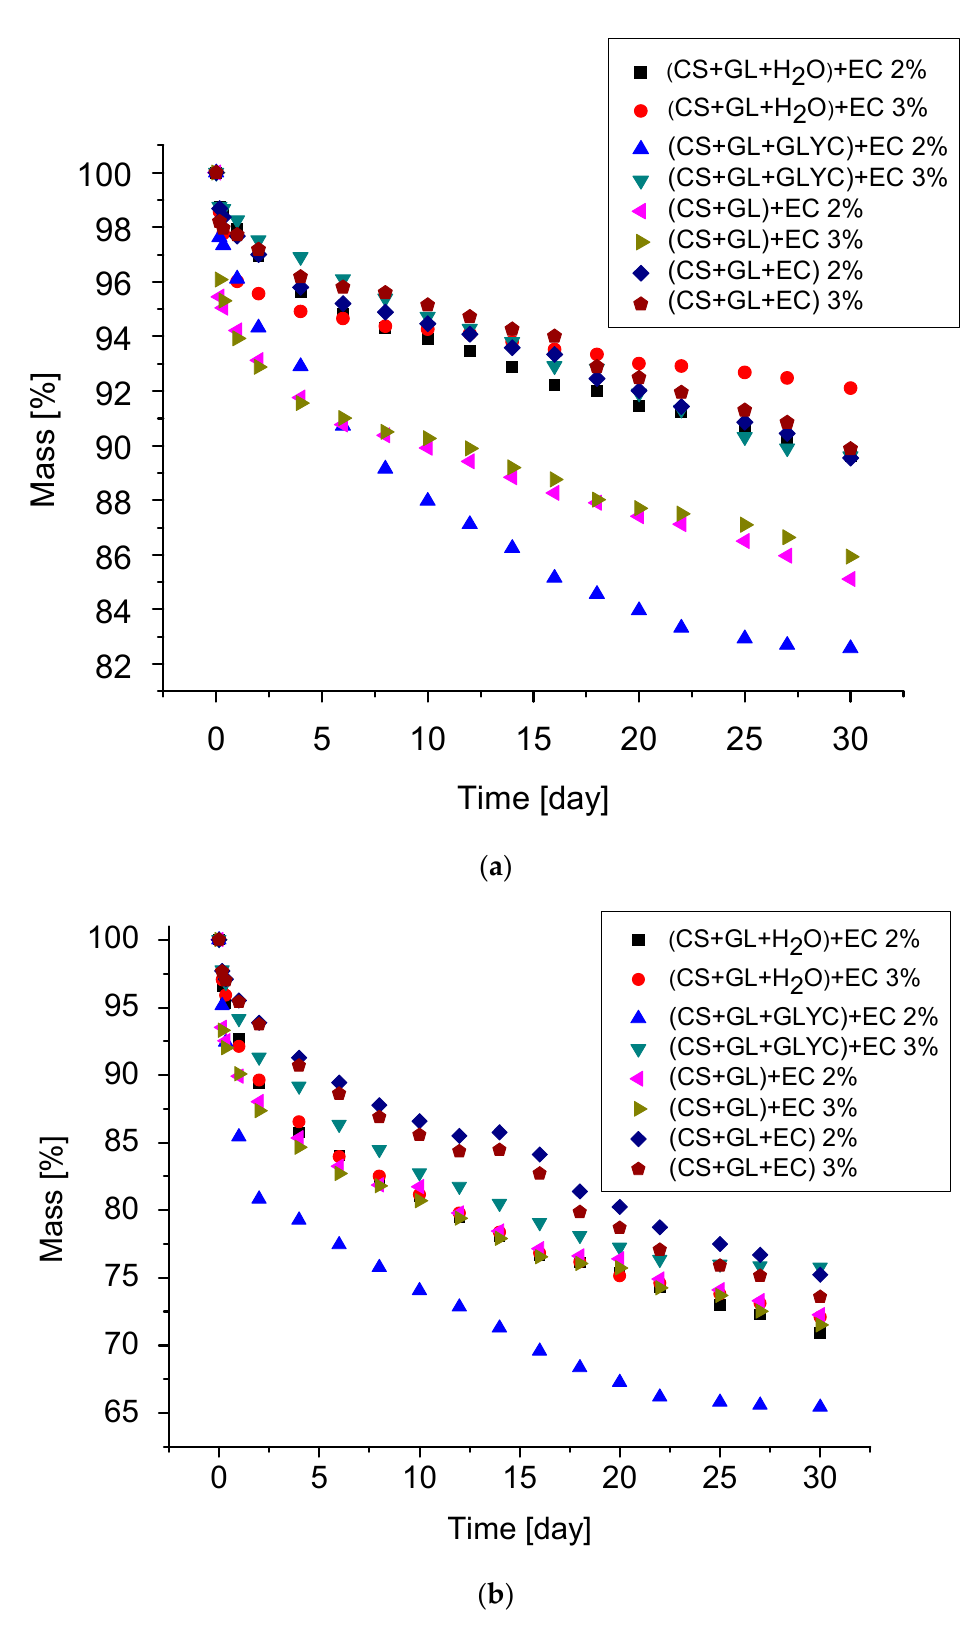
Figure 10. Thermal stability of the polyurethane foam as the mass loss after heating at 150 °C ( a ) and 175 °C ( b ) (the water content of 2% or 3% of the foam composition is based on 100 g of polyol).